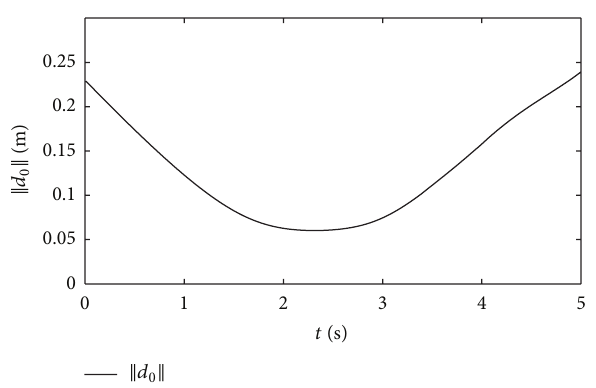
Figure 8: Closest distance using the approach based on transition- ing between tasks.